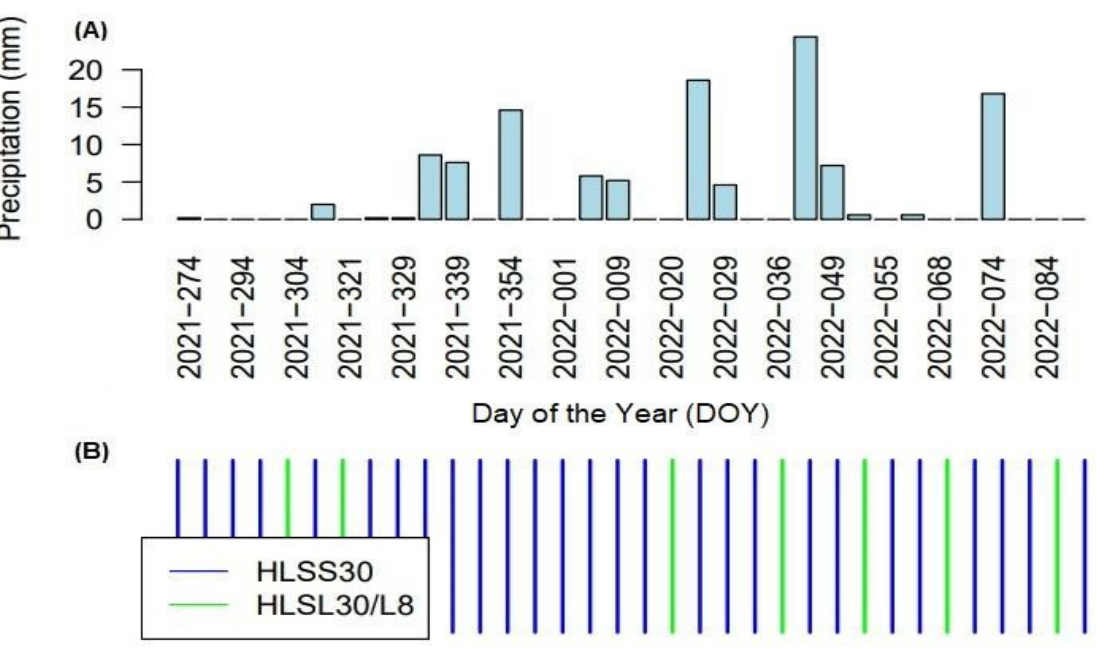
Figure 3. ( A ) Daily rainfall data measured by the automatic meteorological station located in the nicipality of Lu í s Eduardo Magalh ã es during the 2021–2022 crop growing season over the study area. ( B ) Landsat 8 OLI, HLSL30, and HLSS30 images selected during the 2021–2022 crop growing season. Both Landsat 8 OLI and HLS (HLSS30 and HLSL30) images were preprocessed by